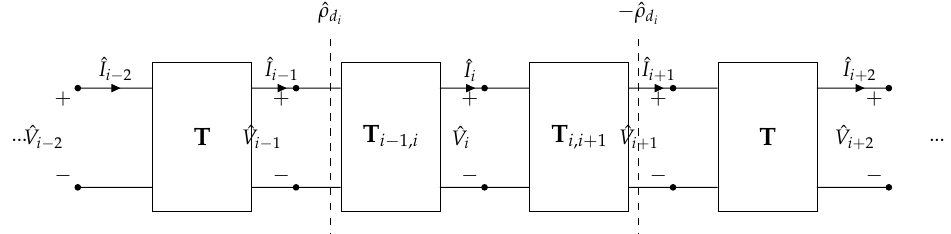
Figure 9. Section of the equivalent TL of a resonator array with a receiver coupled with the i th